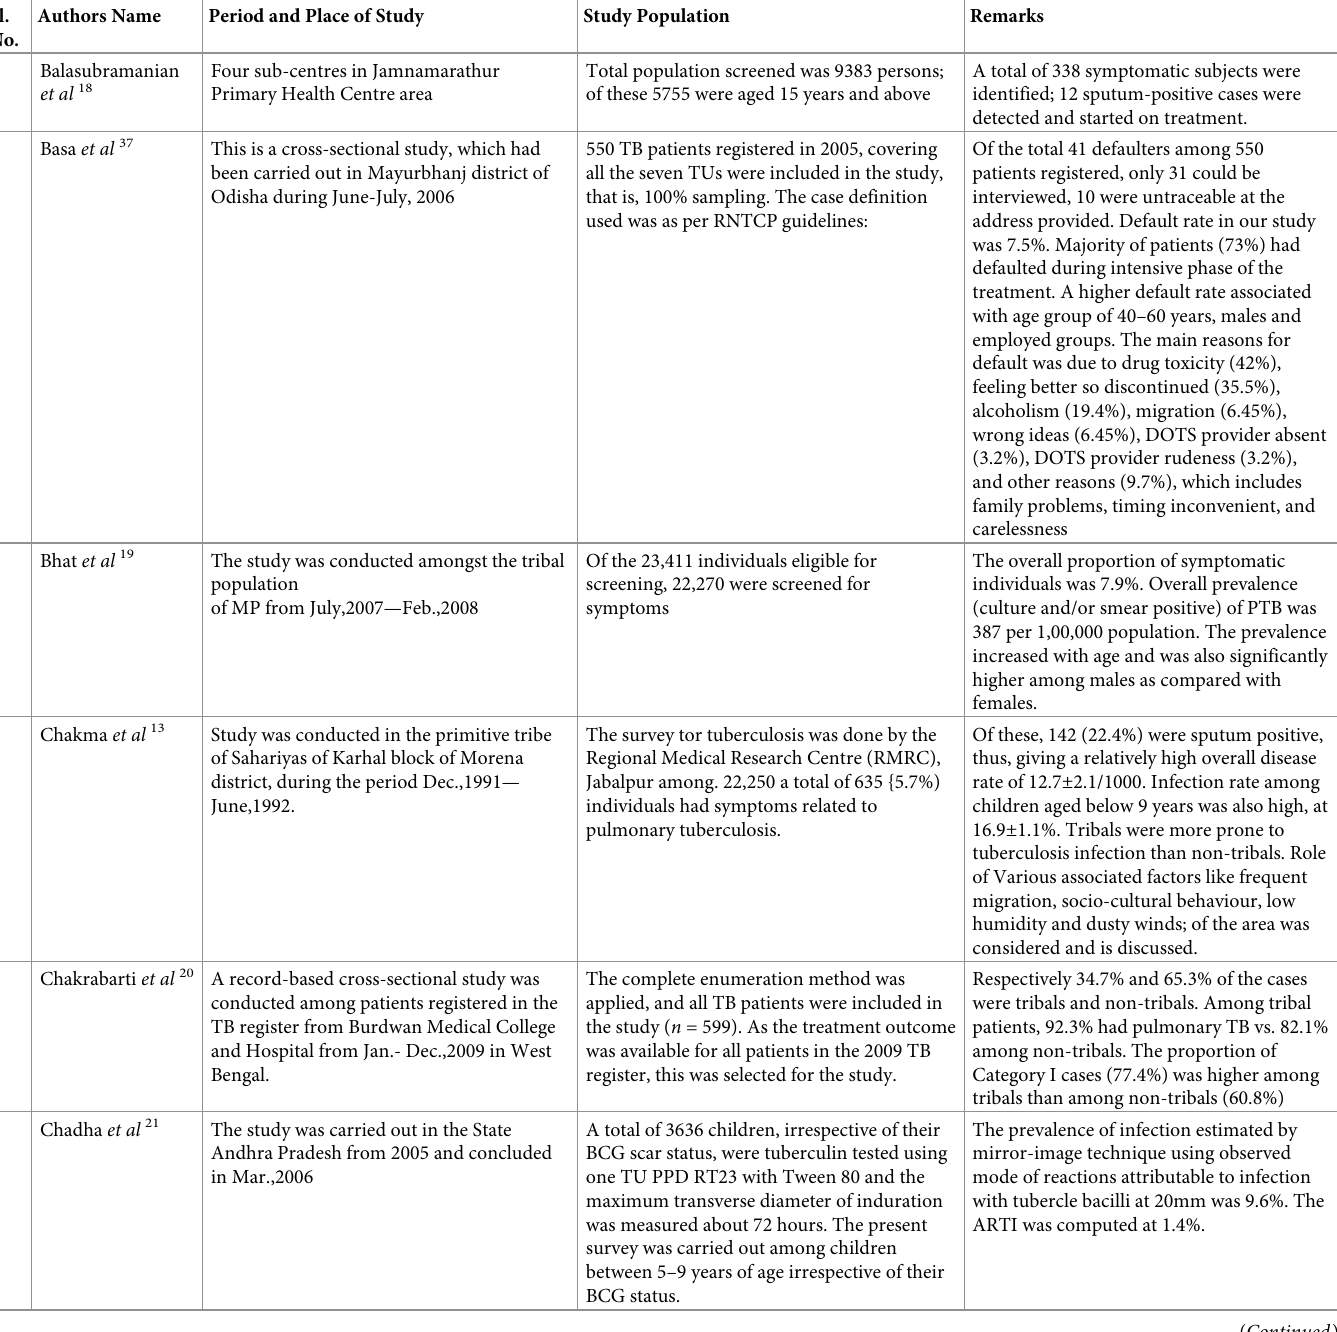
Table 4. Shows the comparative studies on prevalence of TB among tribals in different regions of